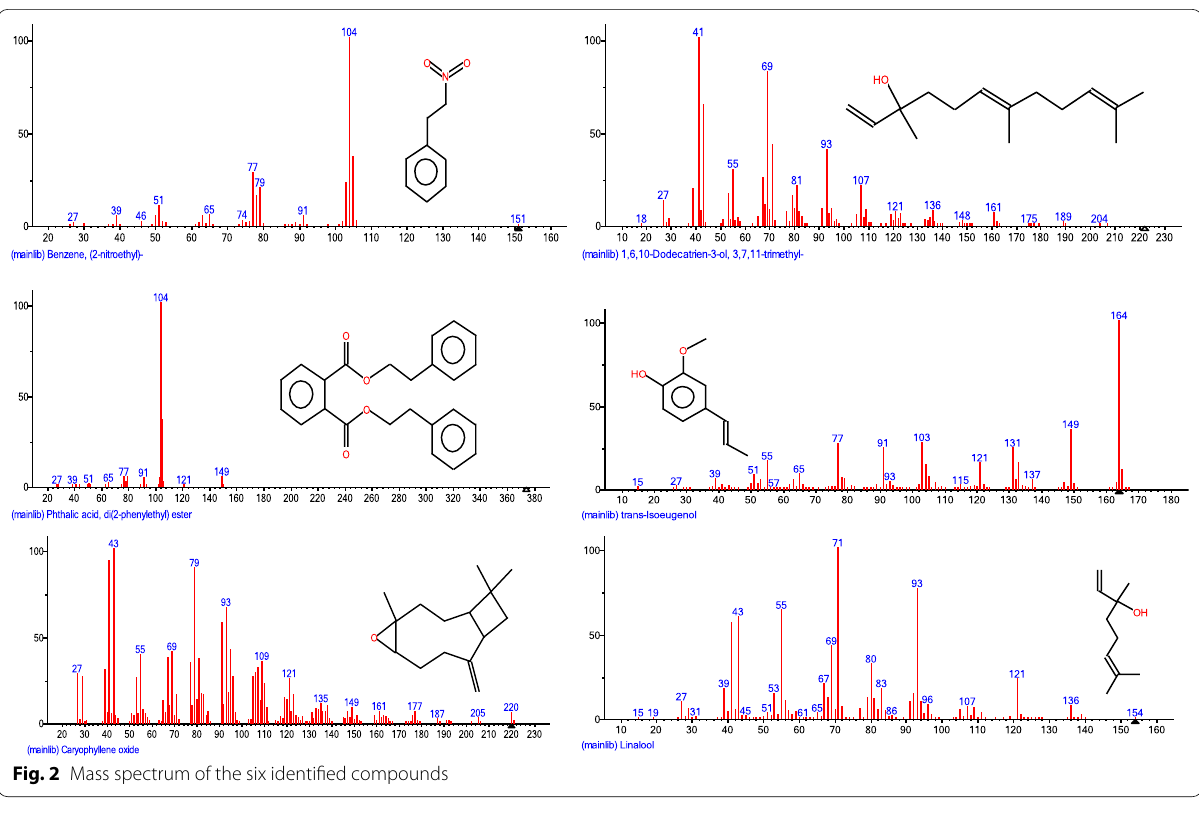
Table 2 Susceptibility of MRSA to various concentrations of Dennettia tripetala Essential Oil Isolate Codes Disk Diffusion: zone of inhibition